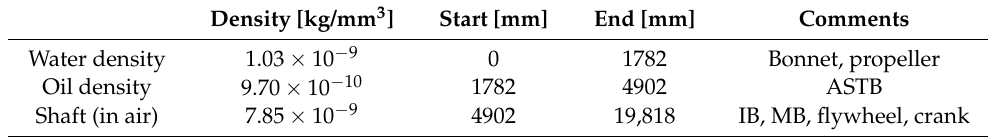
Table 11. Fluid density in contact with shaft FE model.